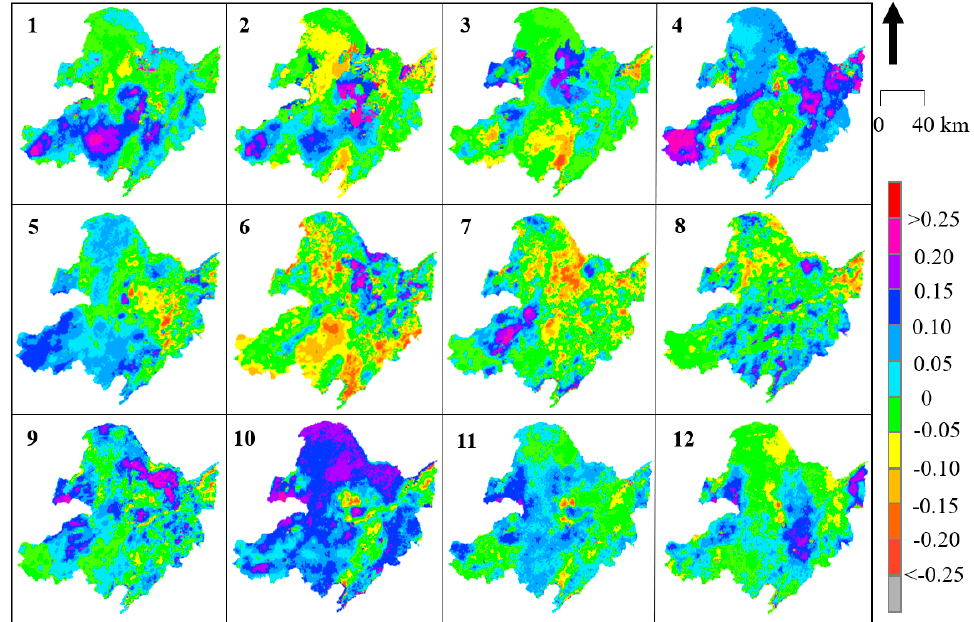
Figure 6. Trends in Slope for the mean monthly downscaled daytime SM from 2002 to 2018 in NEC.